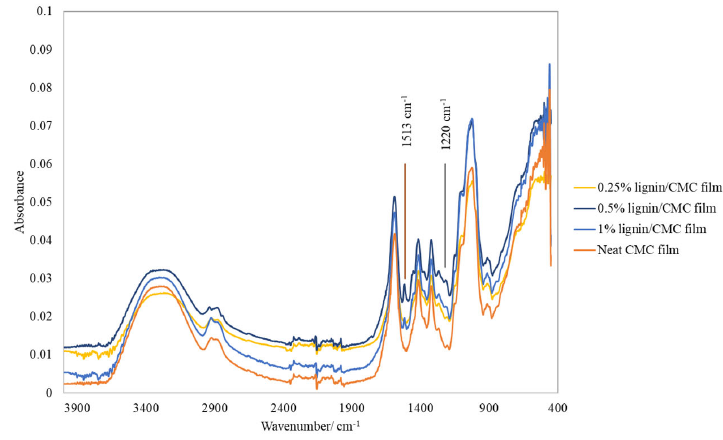
Figure 4. FTIR spectra of lignin/CMC films, from 4000–400 cm − 1 . Table 1. FTIR spectral bands assignment for the lignin/CMC films, with comparison to literature values from [11,28,30,42,43] .